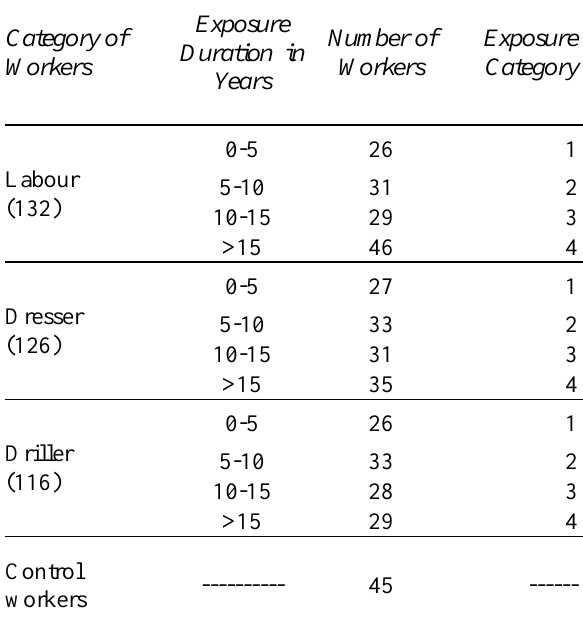
Table 2: Category of workers and exposure duration